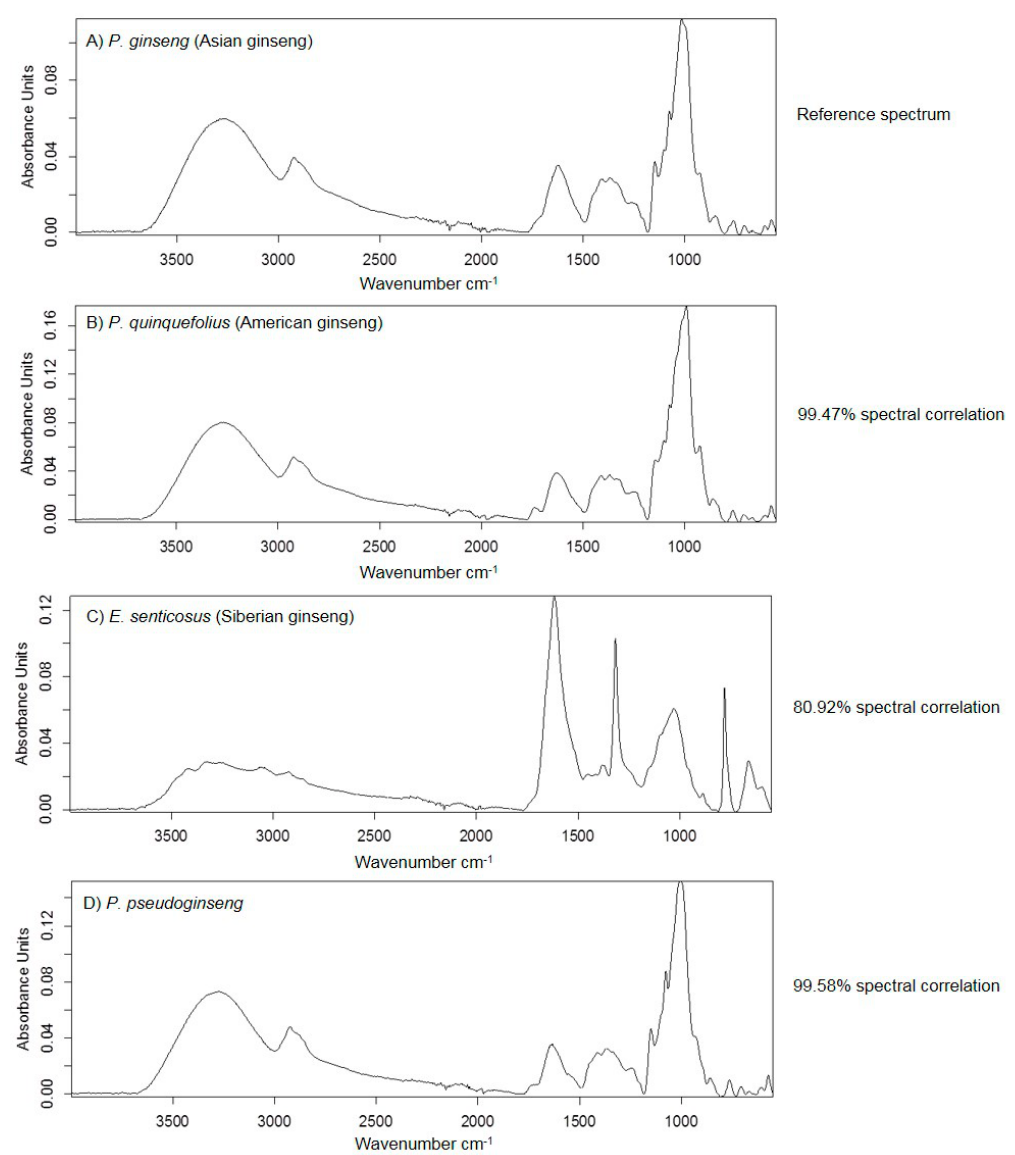
Figure 4. Spectral correlation of different ginseng species to P. ginseng “reference” material. ( A ) The reference material Panax ginseng ; ( B ) Panax quinquefolius ; ( C ) Eleutherococcus senticosus and ( D ) Panax pseudoginseng .